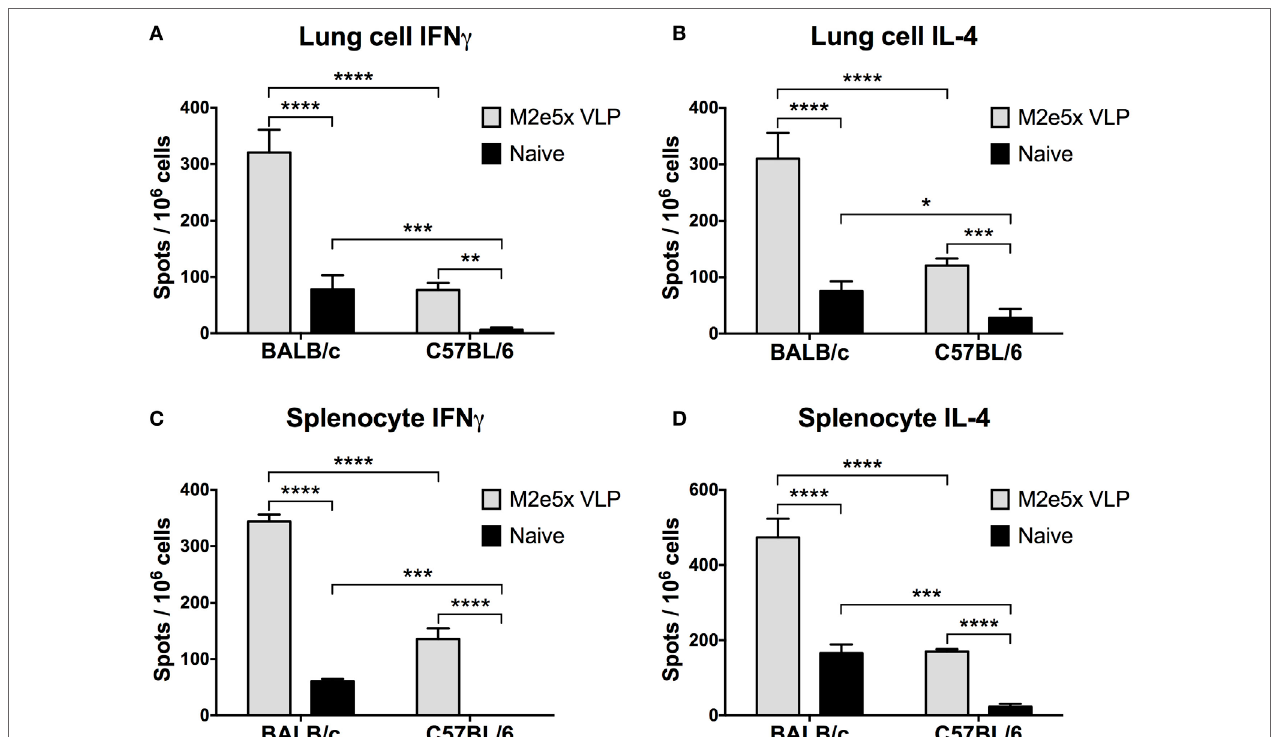
FigUre 3 | Cytokine-producing T cell responses induced by M2e5x virus-like particle (VLP) immunization in C57BL/6 and BALB/c mice after challenge. (a) Interferon (IFN)- γ -secreting cells in lungs. (B) Interleukin (IL)-4-secreting cells in lungs. (c) IFN- γ -secreting cells in splenocytes. (D) IL-4-secreting cells in splenocytes. Lung cells and splenocytes were isolated from C57BL/6 and BALB/c mice previously immunized with M2e5x VLP at day 7 post-challenge (A/Philippines/2/82 H3N2). Cytokine-producing cell spots were counted by ELISPOT reader. Data represent the mean ± SEM. Statistical significances were evaluated by two-way ANOVA. * p < 0.05, ** p < 0.01, *** p < 0.001, **** p <